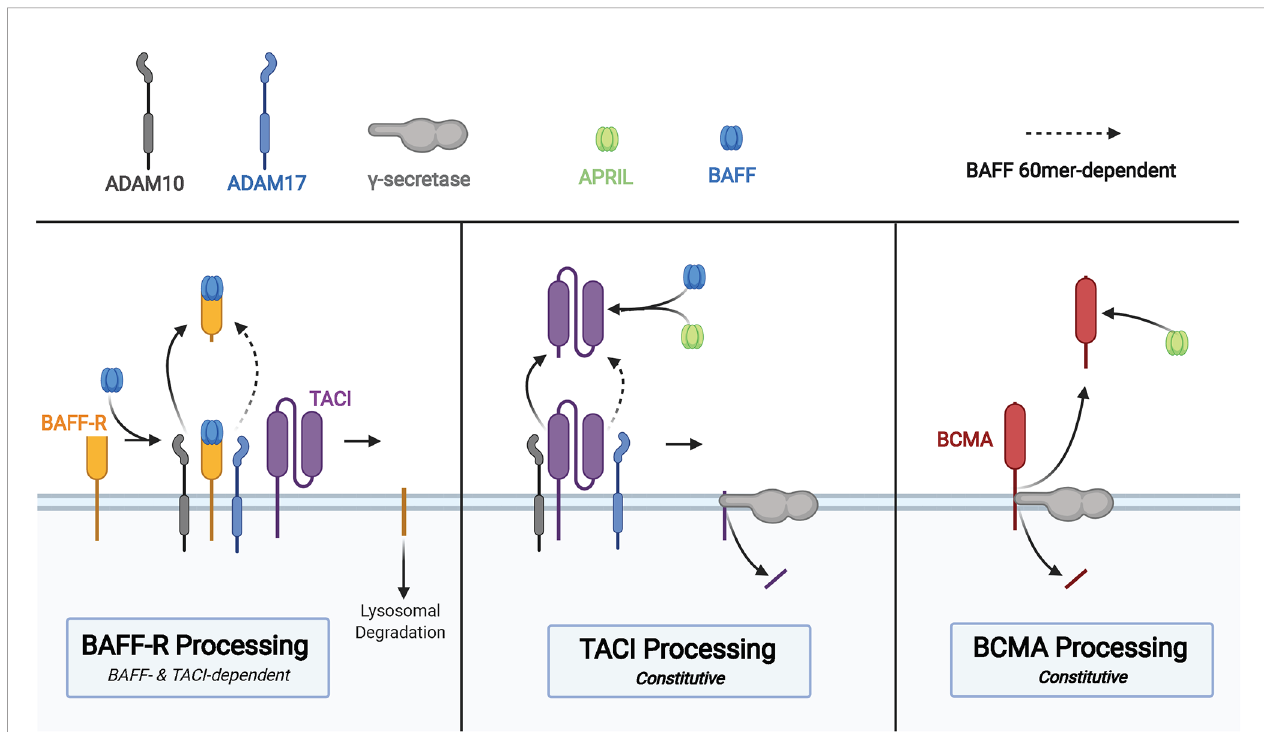
FIGURE 3 | Membrane processing of human BAFF receptors. Cleavage of the BAFF-R ectodomain is induced by BAFF binding in cells that co-express TACI. Processing of BAFF-R by ADAM10 is induced by binding to BAFF trimers and binding of BAFF 60mer to BAFF-R induces ADAM17 processing of BAFF-R. The membrane-bound C-terminal fragment of BAFF-R is degraded in lysosomes after cleavage of the ectodomain. TACI is cleaved in a constitutive manner by ADAM10, followed by cleavage of the membrane-bound C-terminal fragment by g -secretase. sTACI exhibits homotypic assembly and binds to BAFF and APRIL to reduce NF- k B activation and B cell survival, with TACI-Fc demonstrating similar capabilities. BCMA is constitutively cleaved by g -secretase to release sBCMA consisting of the ectodomain and a portion of the transmembrane domain of BCMA. sBCMA is a decoy for APRIL-induced NF- k B activation but does not block BAFF-mediated NF- k B activation. However, BCMA-Fc is capable of binding both APRIL and BAFF to block NF- k B